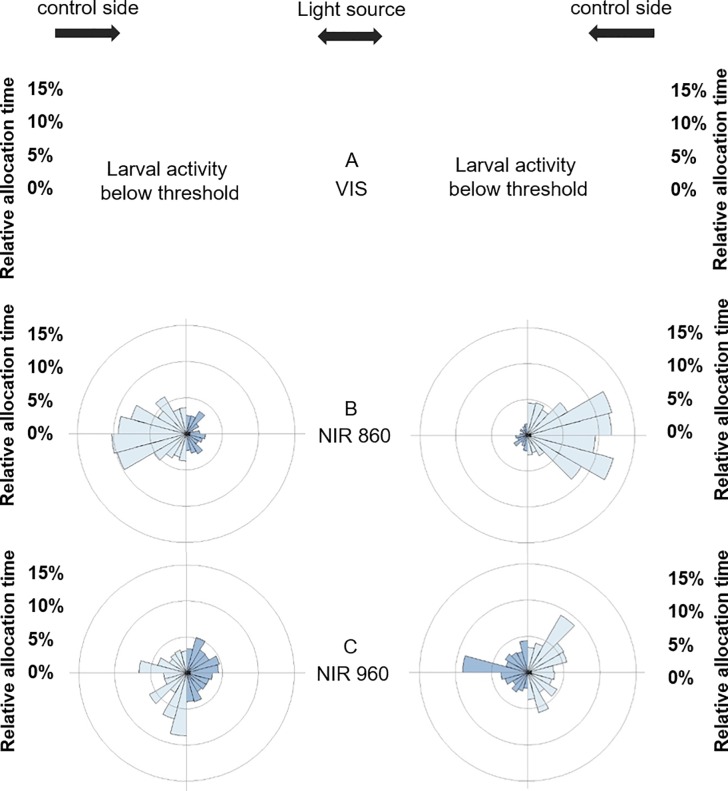
Sector diagram of allocation preference for 96 hpf zebrafish.The blue bars represent the mean allocation time [%] of zebrafish larvae in the test vessel under VIS light (A), NIR light at 860 nm (B) and under NIR light at 960 nm (C). The diagram is divided into 24 sectors, whereby each sector illustrates 15° (Left side: N96hpf/VIS = 2, N96hpf/860 nm = 10, N96hpf/960 nm = 9; Right side: N96hpf/VIS = 1, N96hpf/860 nm = 12, N96hpf/960 nm = 11; except larvae below 20% activity threshold).